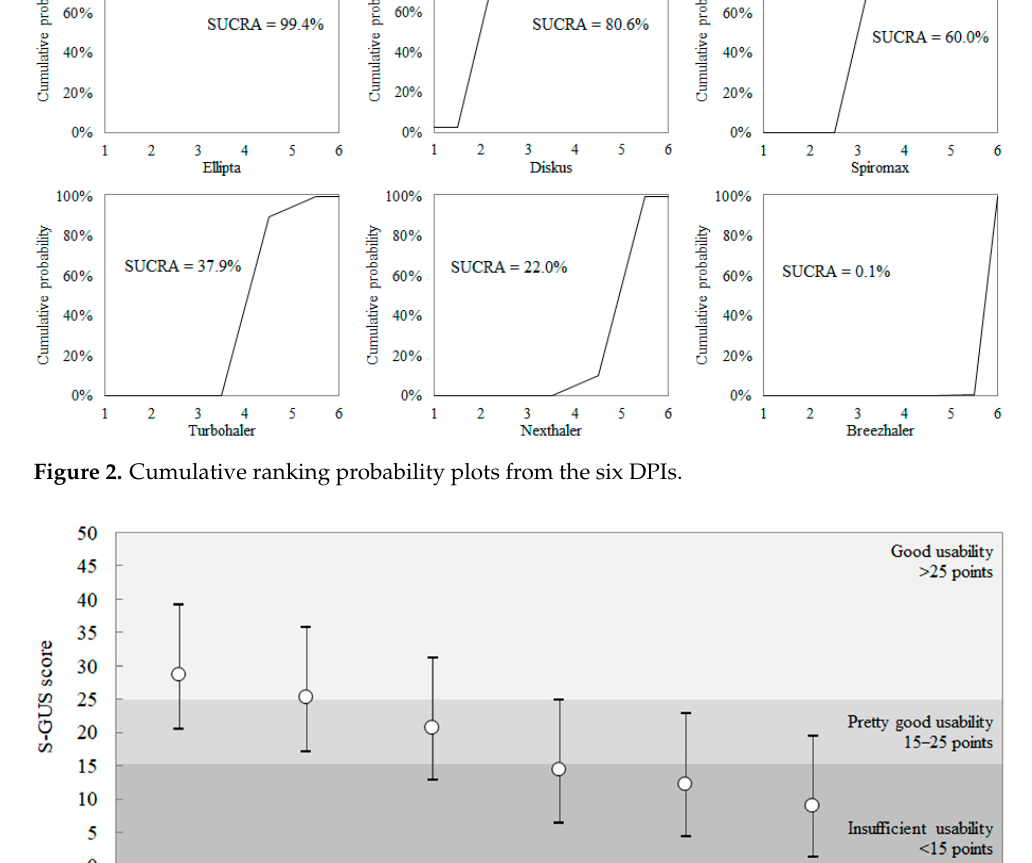
Figure 3. The thresholds for ranking DPI usability by means of the estimated S-GUS scores: white points represent the mean S-GUS, while the bars indicate the 90% credibility interval.